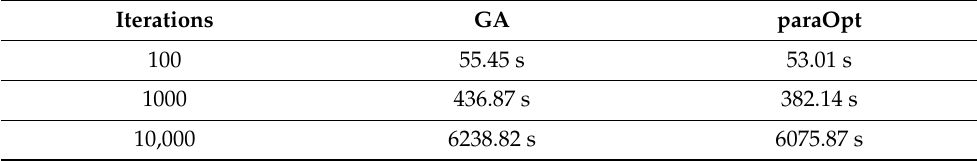
Table 13. CPU time for pattern2 of CFD model